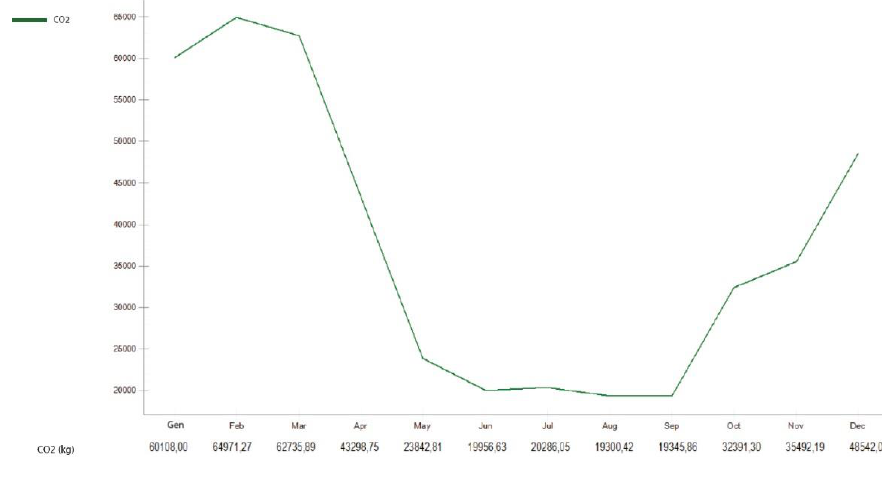
Figure 14. CO 2 production graph.